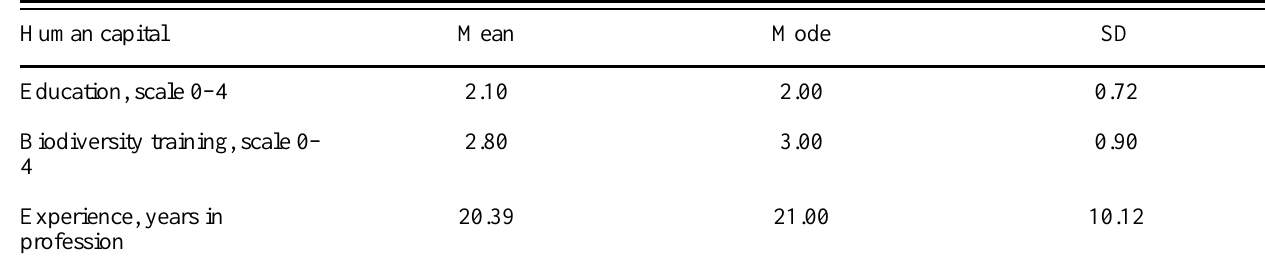
Table A3-1. Descriptive statistics of human capital.